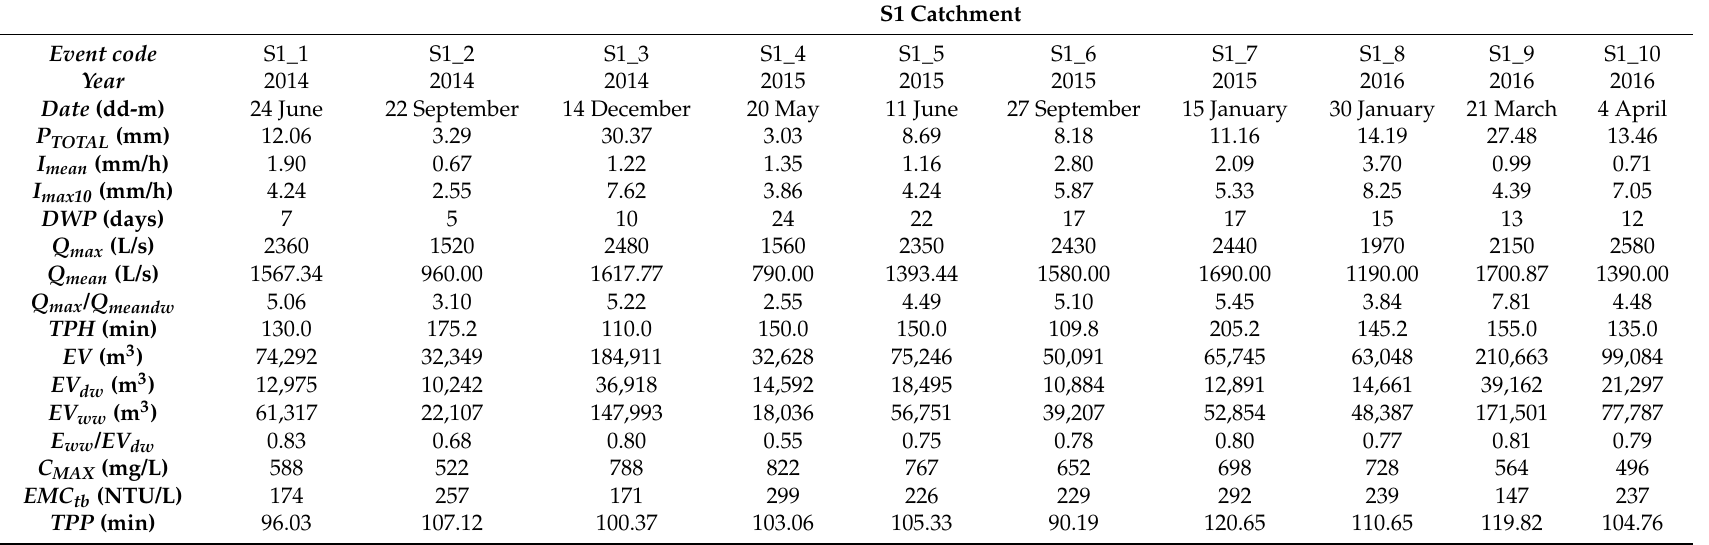
Table 6. Variables of rainfall events at S1